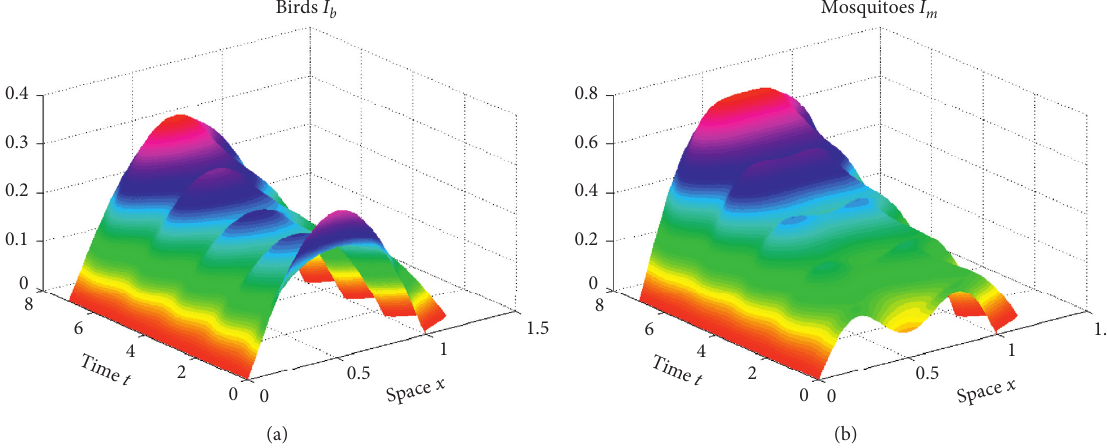
Figure 5: ρ ( t ) � e 0 . 1 ( 1 − cos ( 4 t )) . ρ − 2 < 1, R steady state.